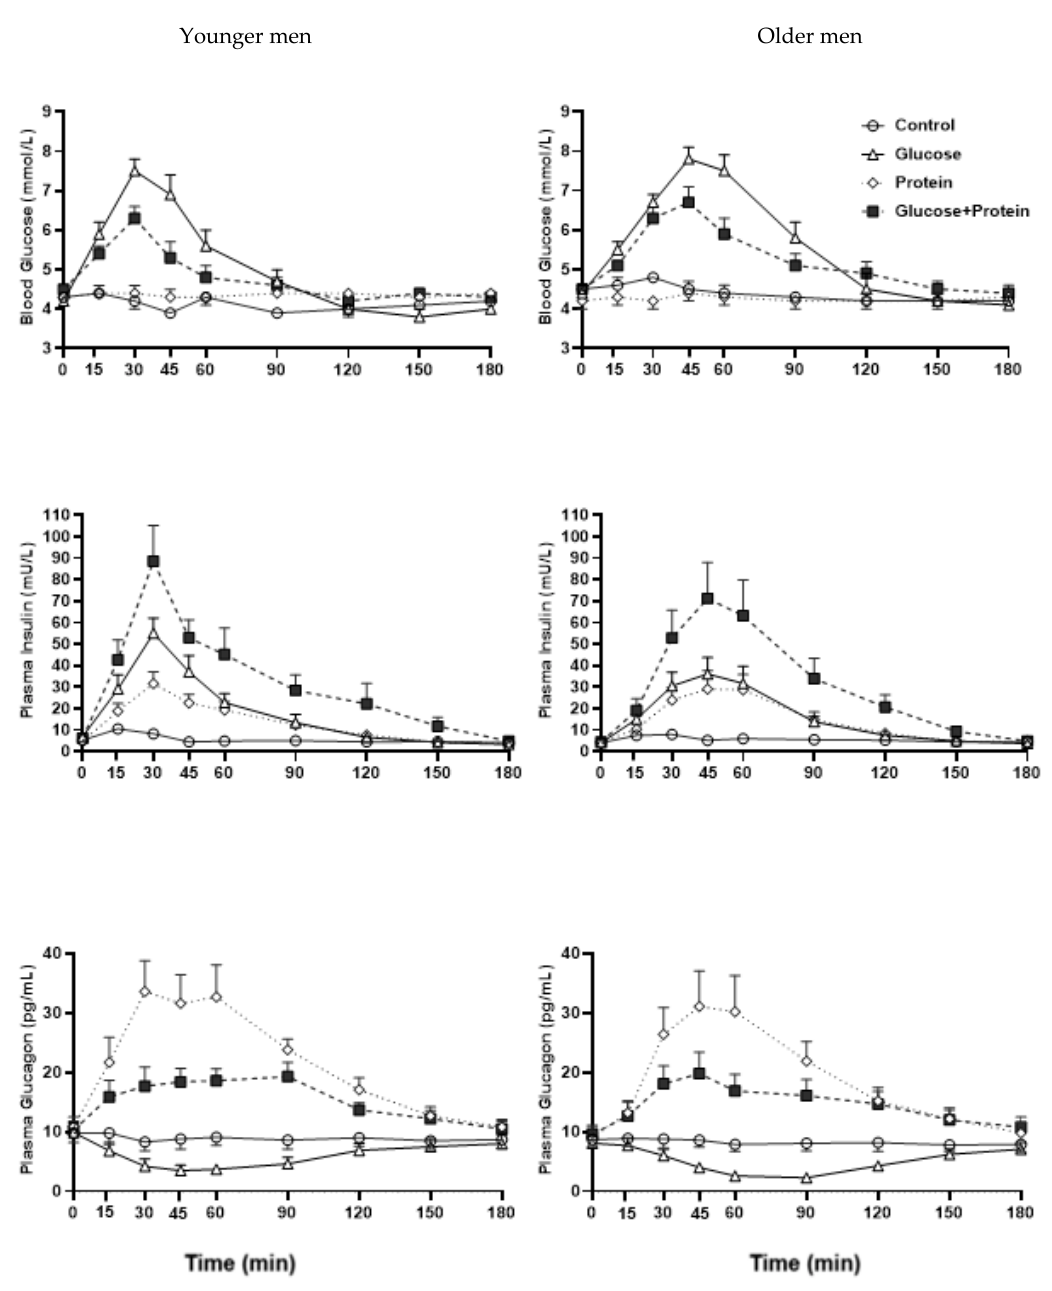
Figure 1. Mean (±SEM) blood glucose (mmol/L), plasma insulin (mU/L) and glucagon (pg/mL) concentrations following drink ingestion containing (i) flavored water (C, control, ~2 kcal), (ii) 30 g whey protein (P), (iii) 30 g glucose (G) or (iv) 30 g whey protein plus 30 g glucose (GP) in younger and older men. Effects of age and drink condition and the interaction effect were determined using a mixed-effect model with baseline concentrations as covariates and post hoc Bonferroni correction. T = 0 min refers to the point immediately before the drink consumption. Age by drink-condition interaction effects : peak insulin ( p = 0.006) was higher after G than P in younger but not older men; time to peak glucose ( p = 0.03) and insulin ( p = 0.038) was longer after G in older than younger men. Drink-condition effect : p < 0.001 Net iAUC glucose GP < G; p = 0.002 Net iAUC insulin GP > G; p < 0.001 peak glucagon P > GP. Age effect : time to peak glucose ( p = 0.007) and insulin ( p = 0.001) occurred later in older than younger men; time to return to baseline glucose ( p = 0.03) and insulin ( p = 0.01) occurred later in older than younger men.